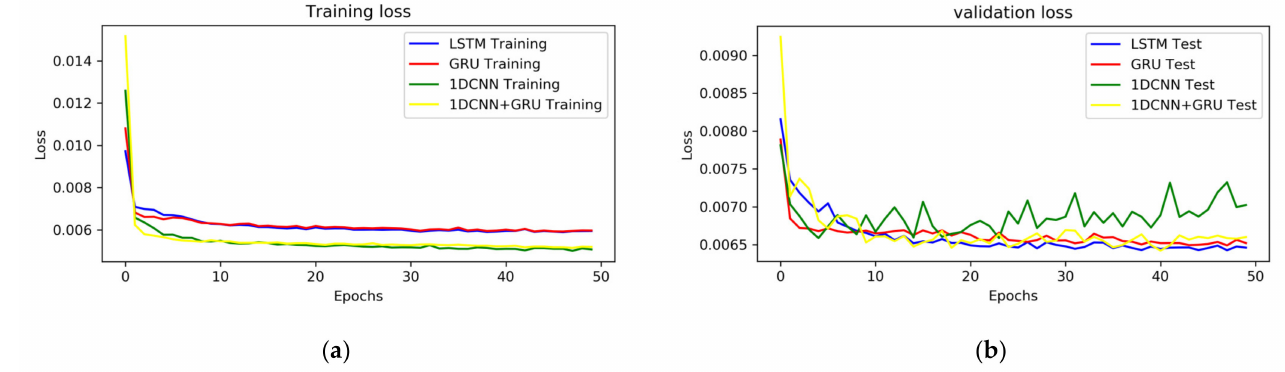
Figure 5. Loss function diagram. ( a ) Training set loss function. ( b ) Validation set loss function.